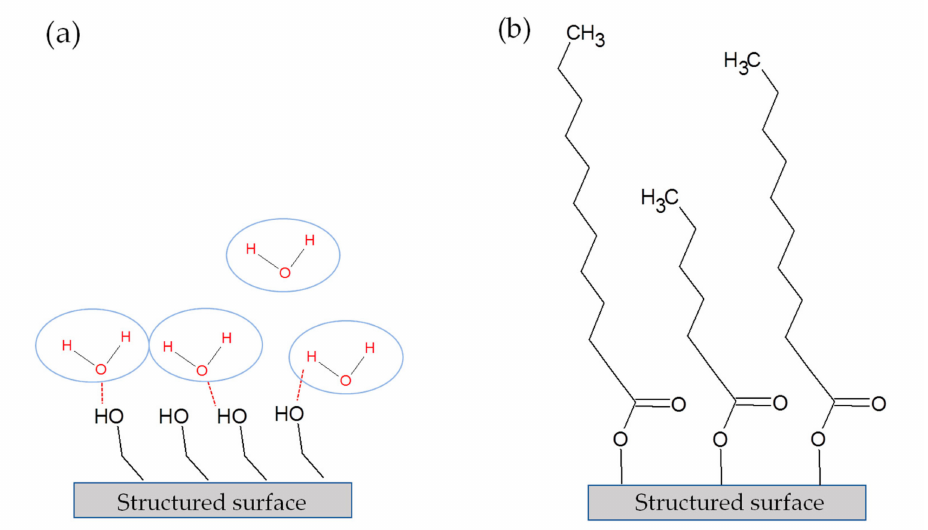
Figure 7. Exemplary schematic illustration of the adsorption of organic molecules on ethanol cleaned structured surface. ( a ) Structured surface immediately after cleaning. ( b ) Structured surface after a period of 14 days after